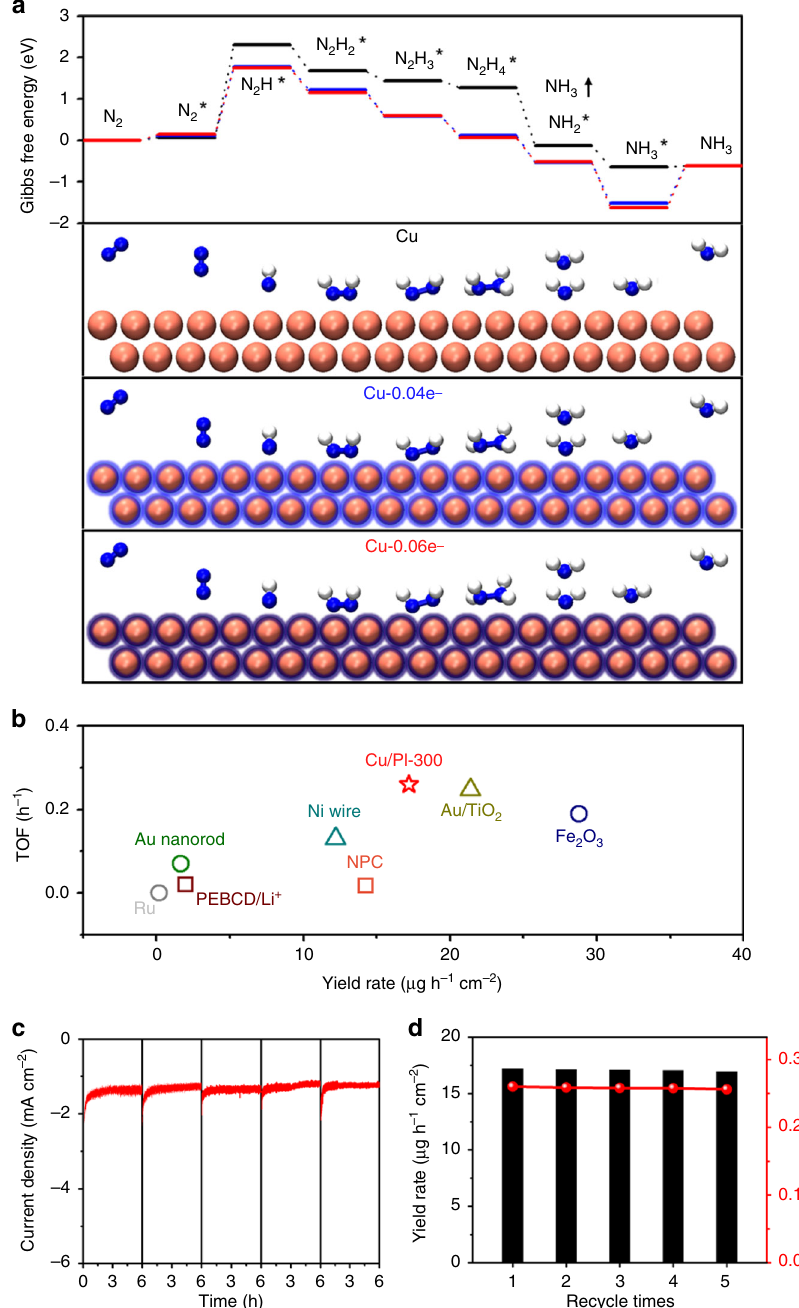
Fig. 4 Density functional theory calculations and stability. a Calculated absorption con fi gurations (bottom) and corresponding Gibbs free energy diagrams of each step of NRR process on pristine Cu (black), Cu-0.04e − (blue) and Cu-0.06e − (red) models. b The turnover frequency (TOF) values and NH 3 generation yield rates of Cu/PI-300 and benchmarked NRR electrocatalyst in the literature (details listed in Table S3). The i-t curves c of fi ve runs of 6-h NRR reaction over a reused Cu/PI-300 at − 0.4 V vs. RHE and corresponding NH 3 yield rates and TOF values